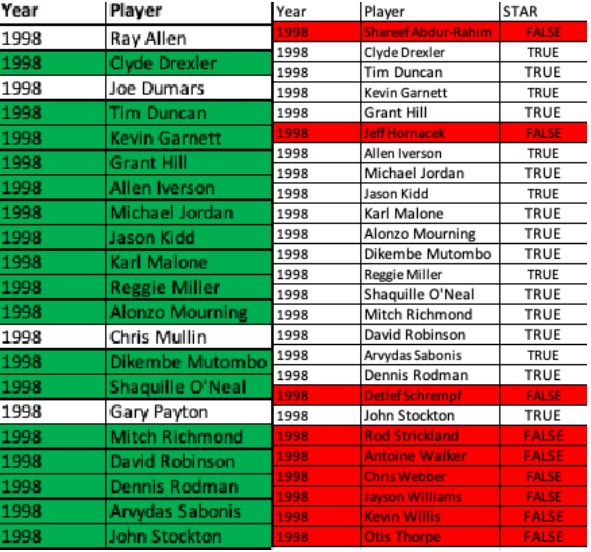
Figure 4. Sample of ANN performance. Green: hits. Red: